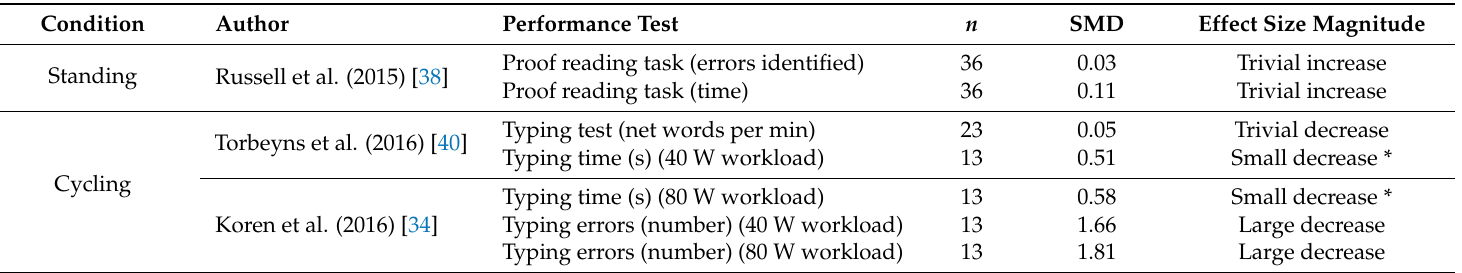
Table 6. Effect of active workstation use on work-related performance